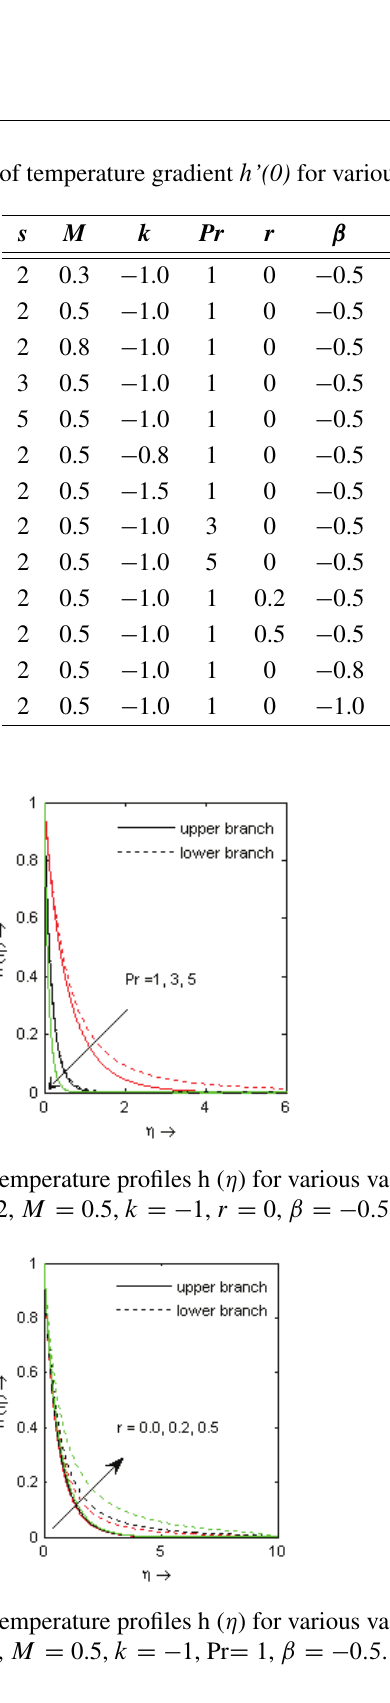
1 , Pr 0:5: 2, M 0.5, k 1, ˇ D D D (cid:31) D D (cid:31)